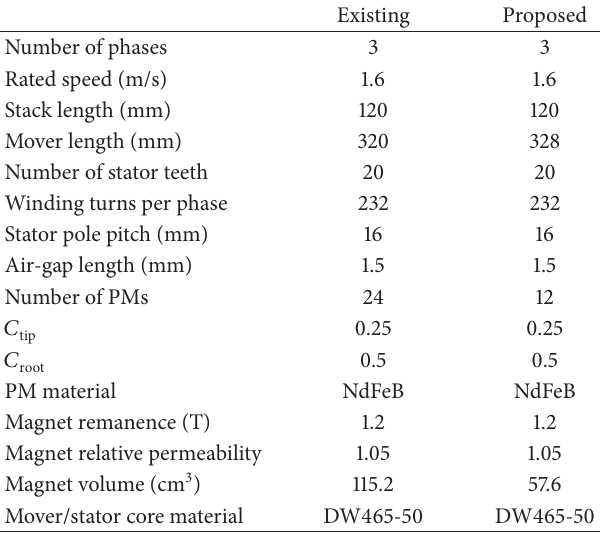
Table1:DesignparametersofexistingLVHandproposedLFTPMV machines.